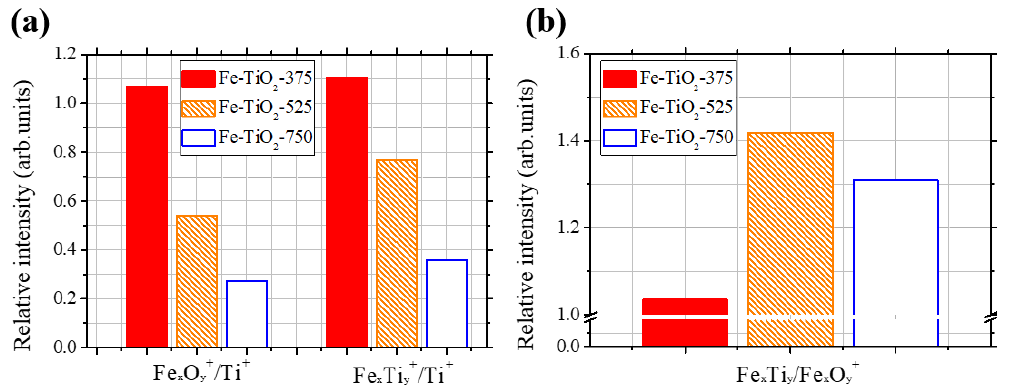
Figure 5. Results of TOF-SIMS analysis. ( a ) Secondary ion mass signals detected during TOF-SIMS analyses on Fe-TiO 2 -375, -525, and -750 samples are compared. Secondary ion mass signals are categorized into two categories (FeO + and FeTi + ), where each category is the sum of the ion mass signals containing the respective ions (e.g., FeO + is the sum of the ion mass signals containing Fe and O). The FeO + and FeTi + signals of each sample were divided by the respective Ti + signal. ( b ) FeTi + signals of three samples divided by the respective FeO + signals are compared.